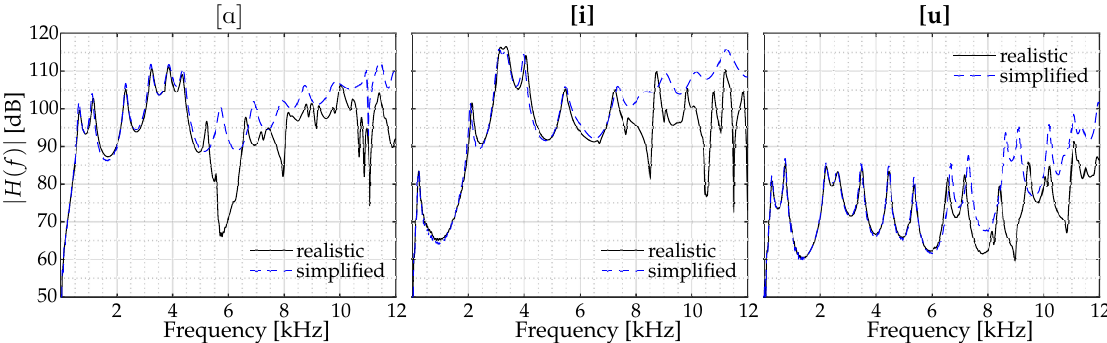
Figure 2. Vocal tract transfer function magnitude | H ( f ) | of vowels [ A ], [i], and [u] for realistic and simplified vocal tract